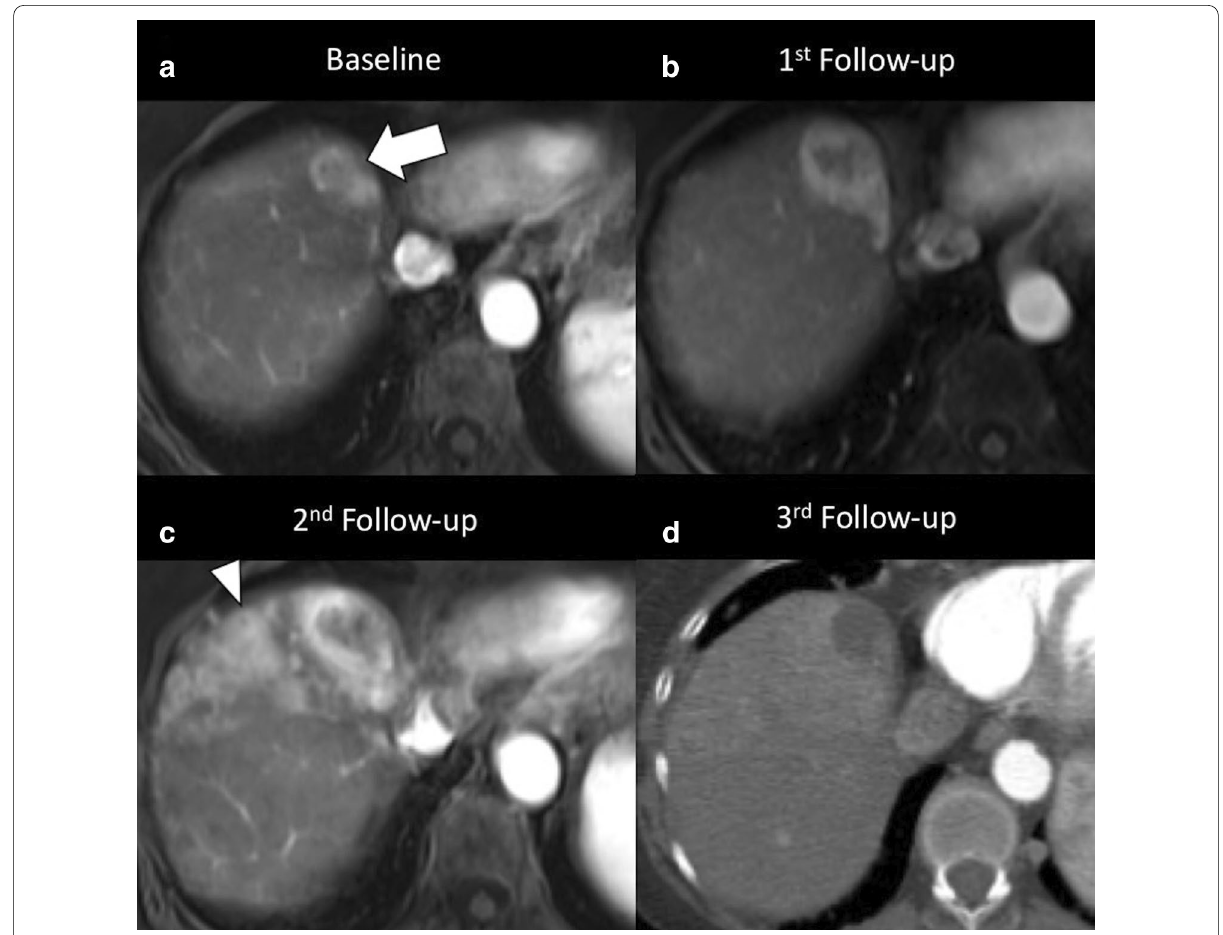
Fig. 17 65-year-old woman with viral cirrhosis and hepatocarcinoma previously treated with transarterial embolization with post-treatment persistence of viable tumor (LR-TR viable), then submitted to stereotactic body RT with radiation dose of 40 Gy in 5 fractions. a